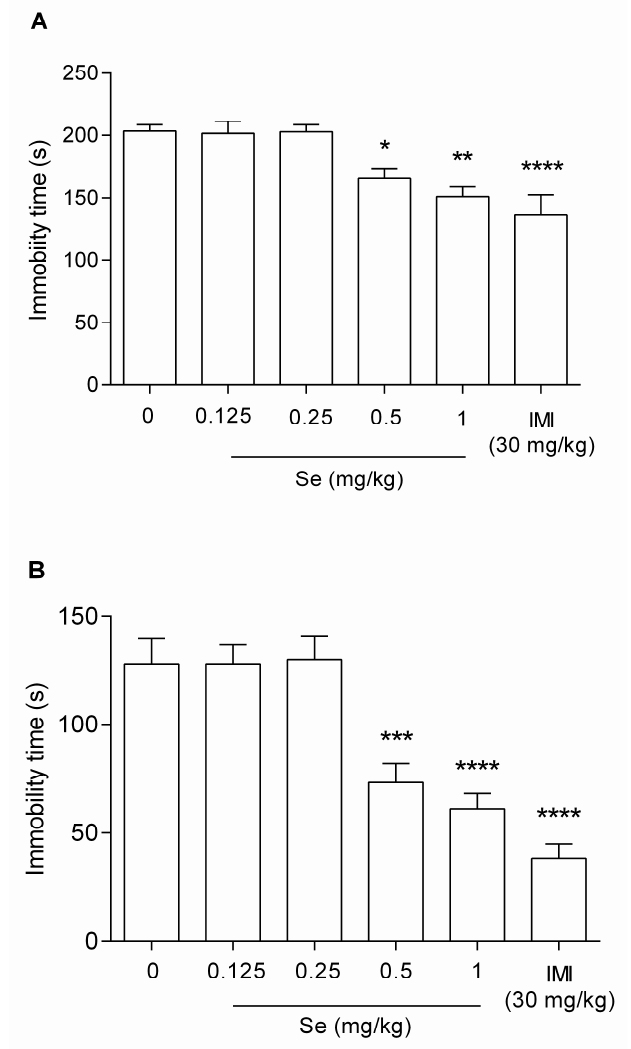
Figure 1. The antidepressant-like activity of sodium selenite in the FST ( A ) and the TST ( B ) in mice. Sodium selenite (Se) and NaCl 0.9% were administered i.p. 30 min, while IMI was given 60 min prior behavioral testing. Data are presented as the means ± SEM. Each experimental group consisted of 8–10 mice. * p < 0.05, ** p < 0.01, *** p < 0.001, **** p < 0.0001 vs. control group (one-way ANOVA followed by Dunnett’s post-hoc